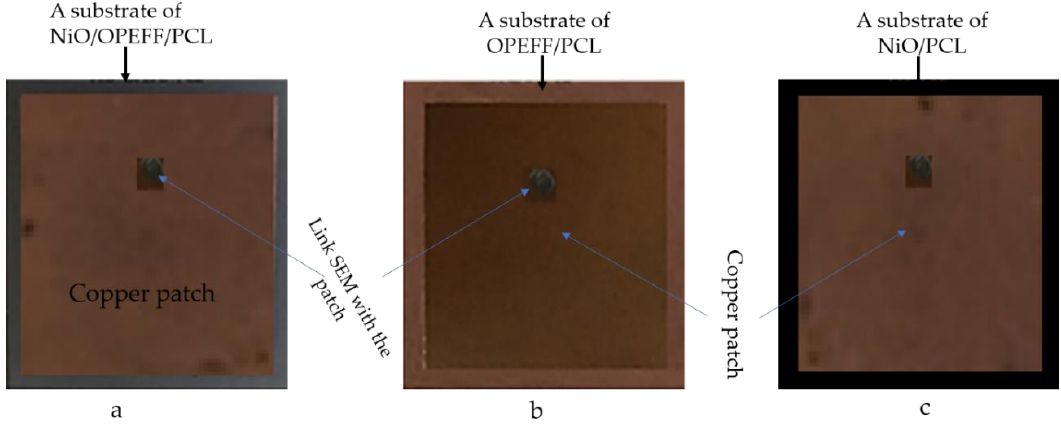
Figure 2. Manufactured microstrip patch antennas ( a ) NiO / oil palm empty fruit fiber (OPEFF) / polycaprolactone (PCL), ( b ) OPEFF / PCL, and ( c ) NiO / PCL based on the fabricated substrates.